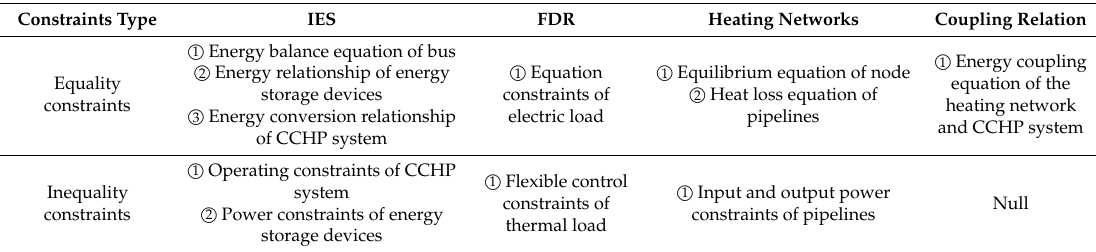
Table 1. Details of